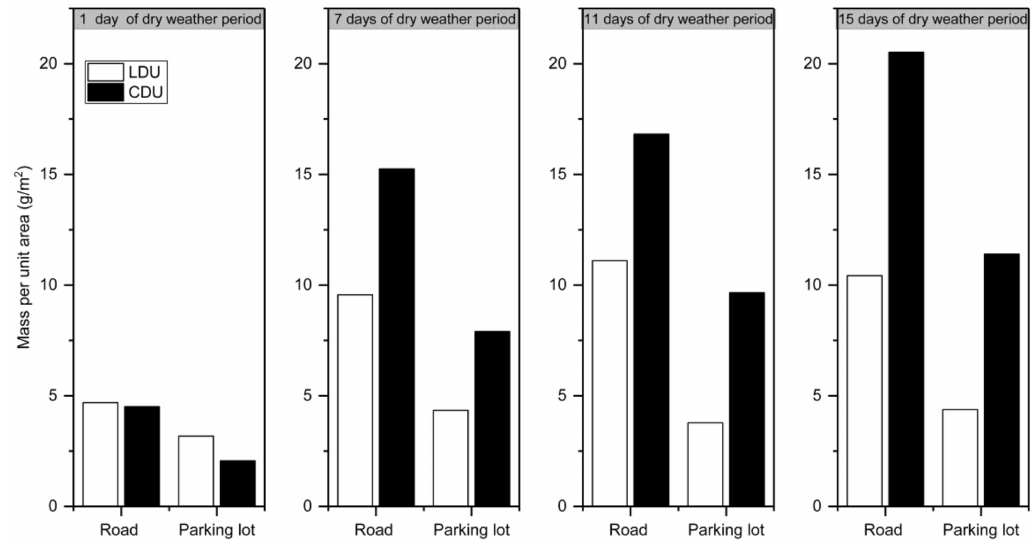
Figure 3. The accumulation process of urban sediments during dry weather in the LID and conventional residential catchment. LDU = LID residential drainage unit; CDU = conventional residential drainage